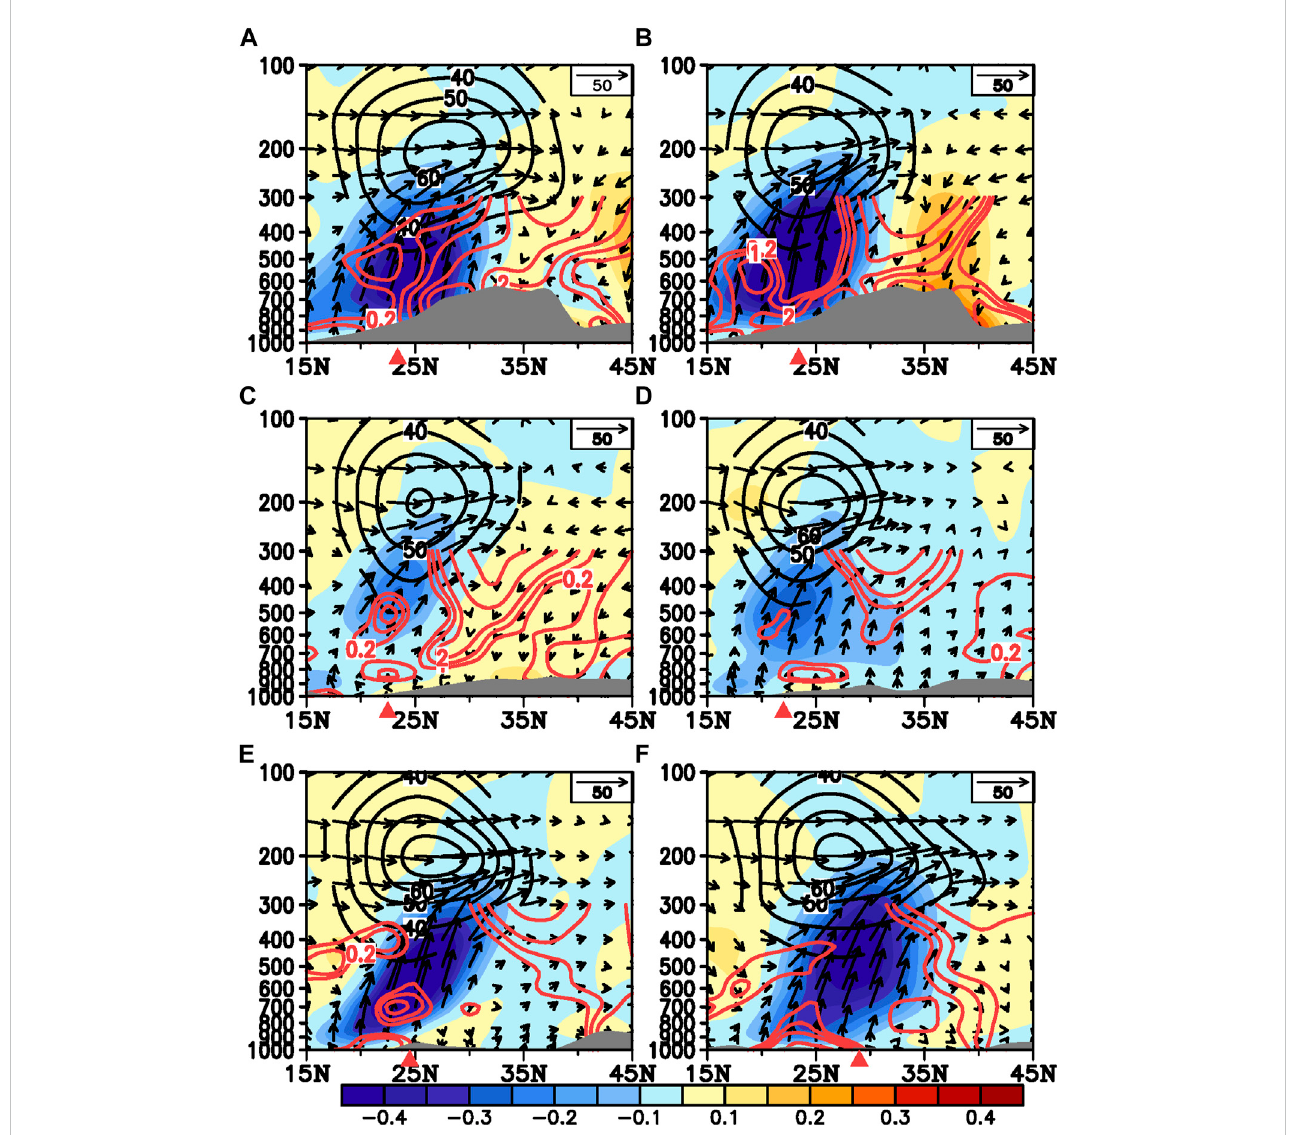
FIGURE 12 Vertical cross-sections along the red dotted lines in Figure 7 for the frontogenesis (positive value as red contours; units: 10 K · m − 1 · s − 1 ), omega fi eld (shading; units: Pa s − 1 ) and wind fi eld (horizontal wind, units: m s − 1 ; vertical omega, units: 10 – 2 Pa · s − 1 ) along (A) 100 ° E on January 8, (B) 100 ° E on January 9, (C) 107 ° EonJanuary10, (D) 110 ° Eon January11, (E) 115 ° EonJanuary 12and (F) 120 ° E onJanuary13 in2015.Theblack contourindicates theupperlevel jetwitha zonal wind speed greater than 30 m · s − 1 . The latitude with the maximum center of daily precipitation is represented by the red triangle. The gray shading shows the shape of the